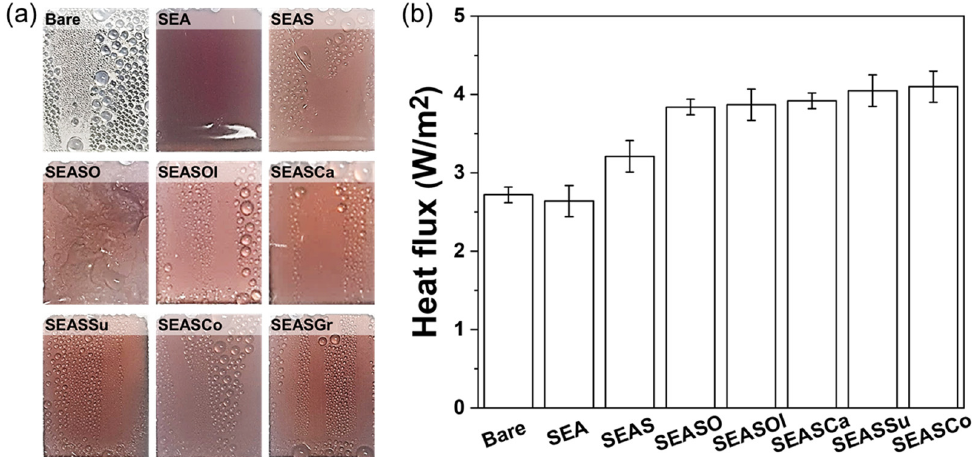
Figure 6. ( a ) The appearance of condensed water on each specimen and ( b ) estimated heat flux by condensation on sample surface.